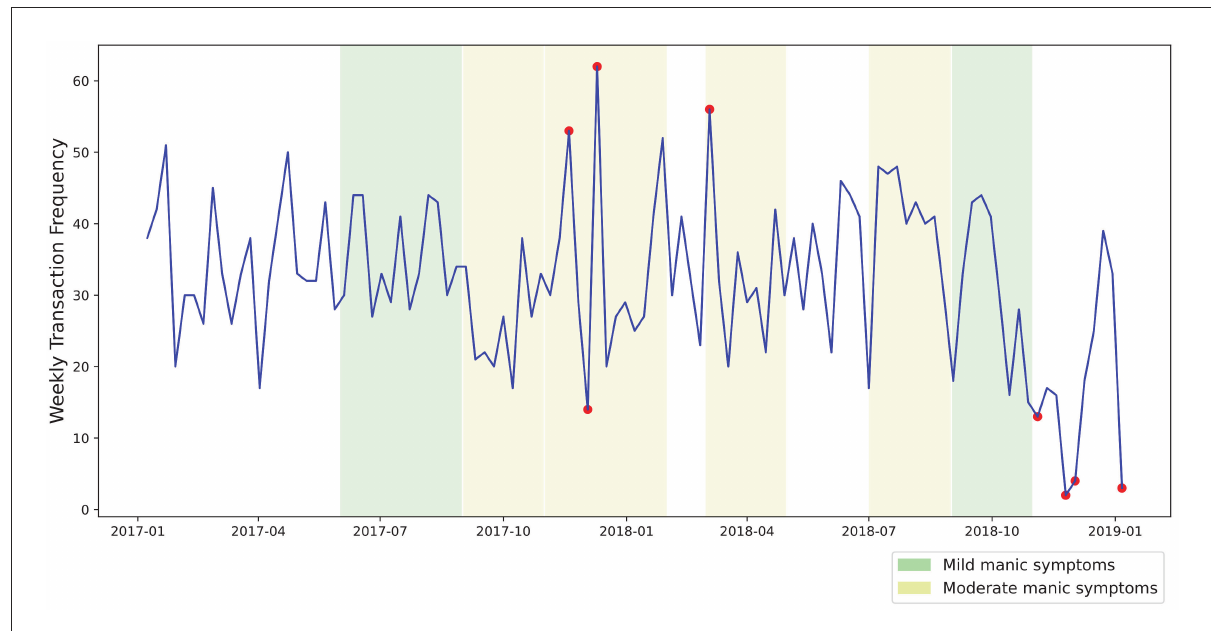
FIGURE5 Outlier periods of spending frequency as identified by an unsupervised isolation forest